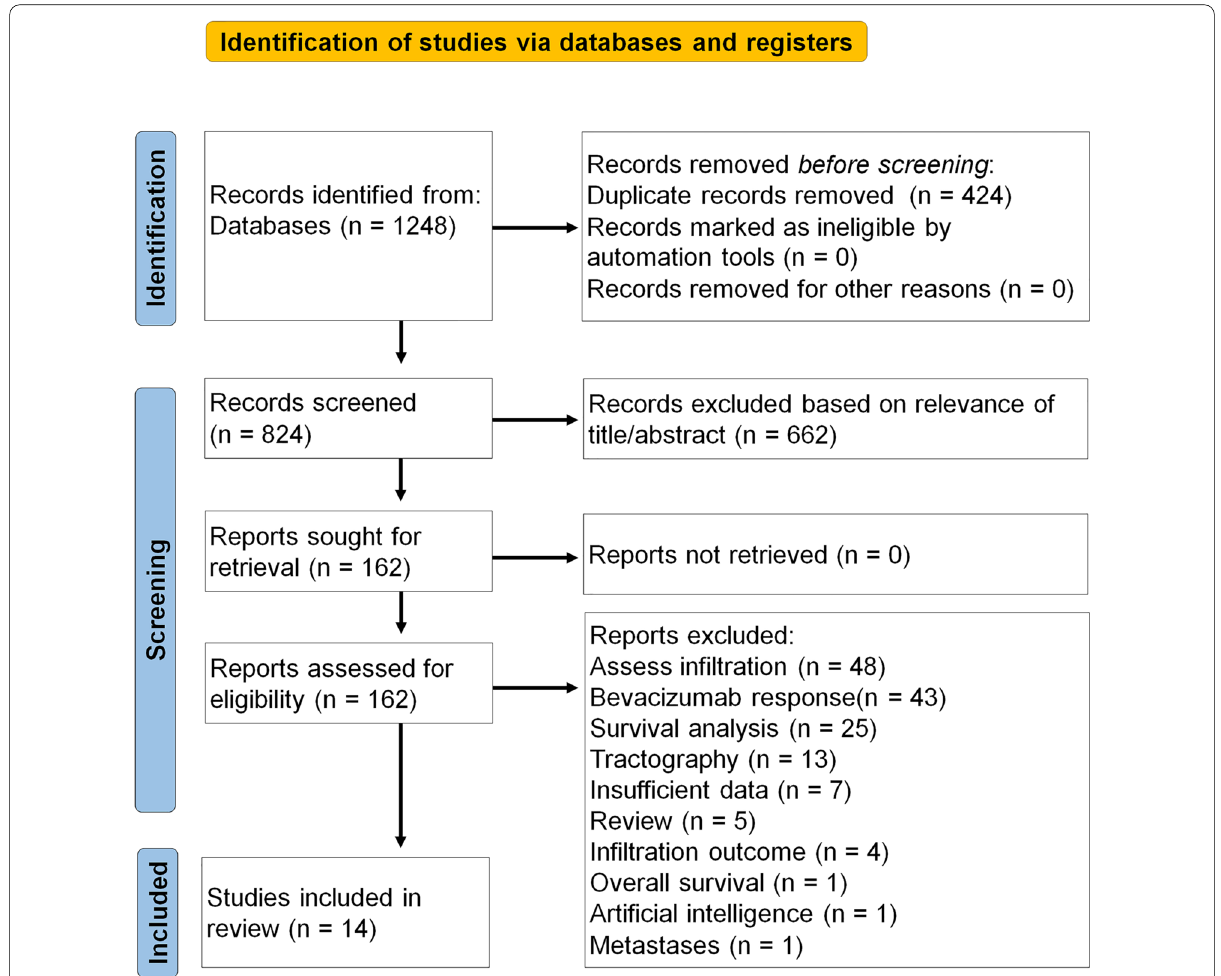
Fig. 1 PRISMA 2020 Flow